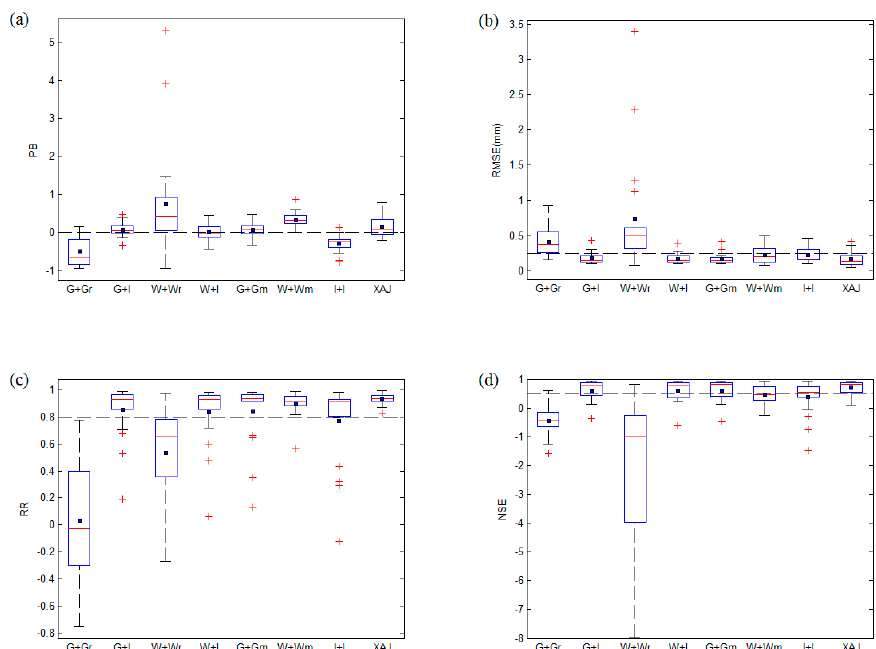
Figure 10. Boxplots of ( a ) PB, ( b ) RMSE, ( c ) RR and ( d ) Nash-Sutcli ff e e ffi ciency (NSE) of events in eight scenarios. The meanings of red line and plus are identical to Figure 5 and blue square is the average. The values of black dotted lines in ( a ), ( b ), ( c ) and ( d ) are 0, 0.25 mm / h, 0.8 and 0.5, respectively. Noted that the distribution of the W + Wr in ( d ) does not contain all points, and the other three outliers are − 13.5, − 34.2 and − 224.7. The mean NSE of the W + Wr, − 15.36, is not shown too. Table 9. The mean values of four metrics shown in Figure 10.